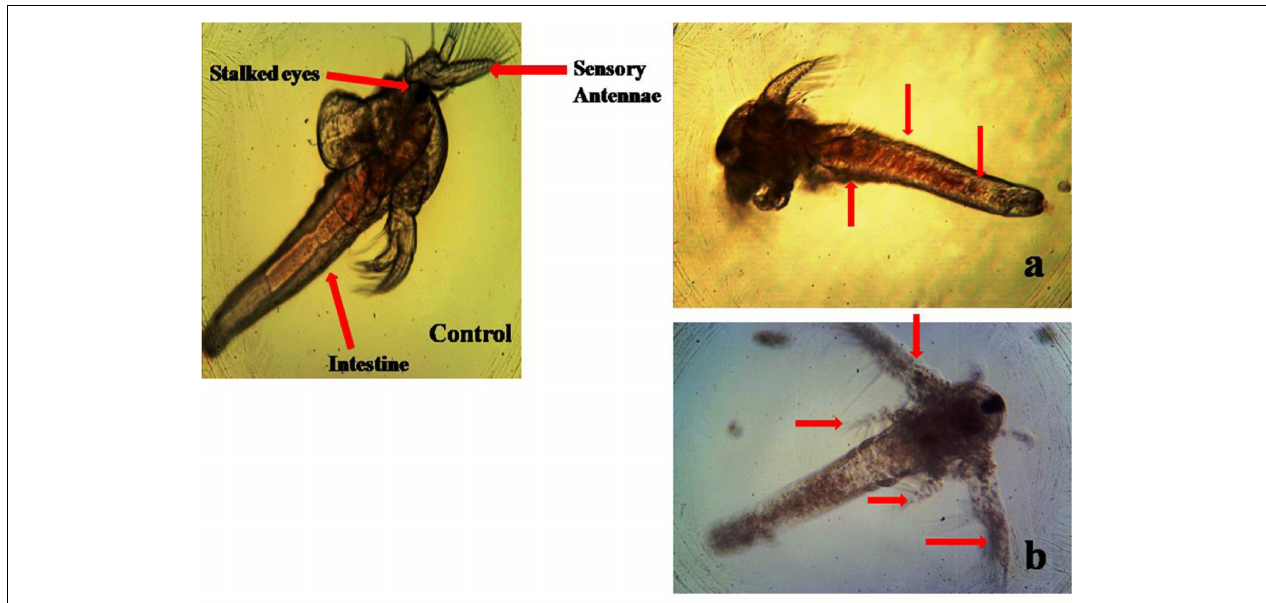
FIGURE 6 | Morphological changes of A. nauplii exposed to P. daleae mycelium ethyl acetate extract. A. nauplii not exposed to extract (control), intestinal enlargement and outer shell anomalies (a) and loss of antennae and deformation of antennae (b)